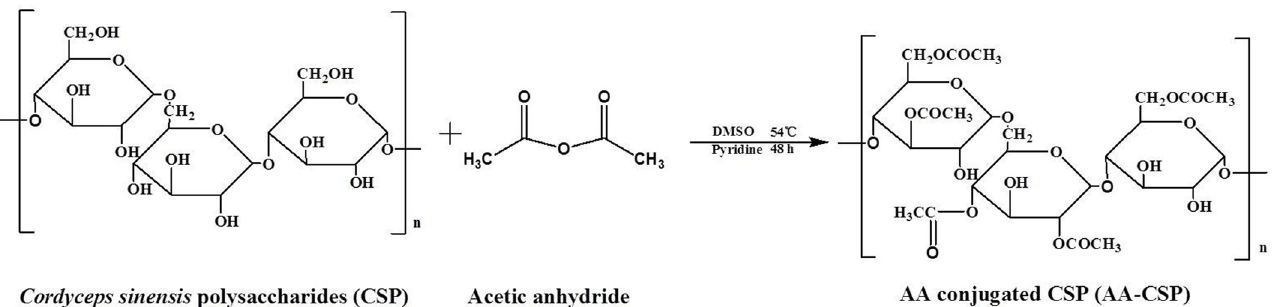
FIGURE 2 - Synthetic route of acetic acid (AA) conjugated Cordyceps. sinensis polysaccharides